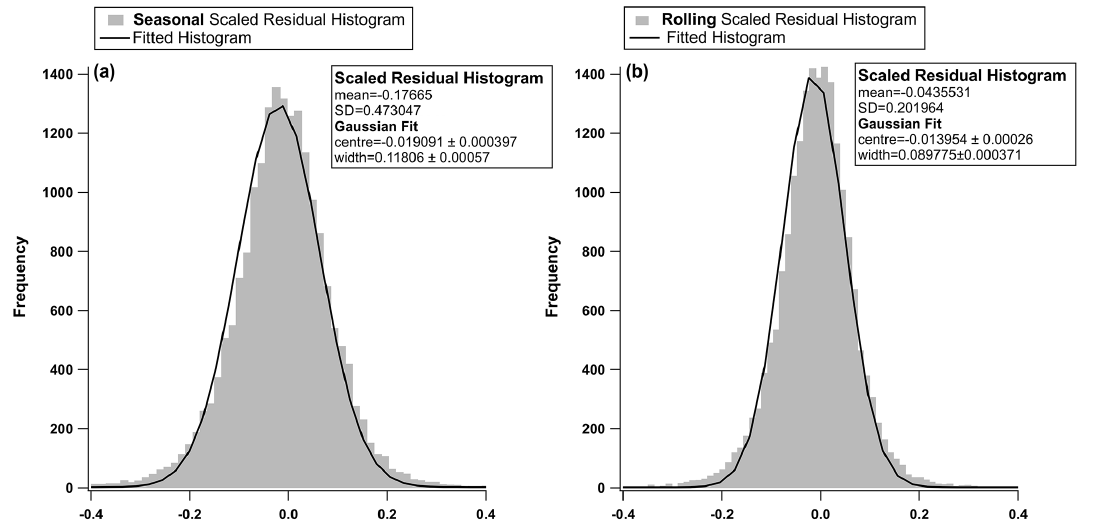
Figure A3. Distribution of the scaled residuals over the whole year for the seasonal solution (a) and the rolling solution (b)